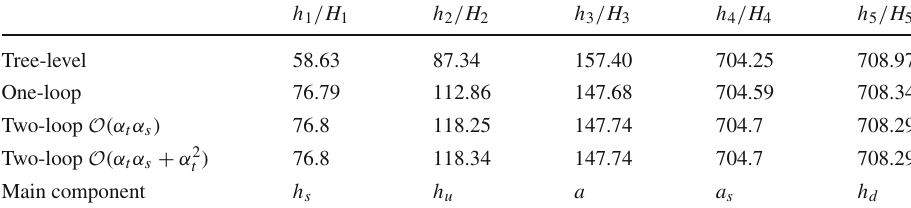
Table 7 Mass values in GeV and main components of the neutral Higgs bosons at tree level, one-loop level, two-loop α ) level, and at two-loop O (α t s α + α 2 ) level obtained by O (α t s t using OS renormalization in the top/stop sector